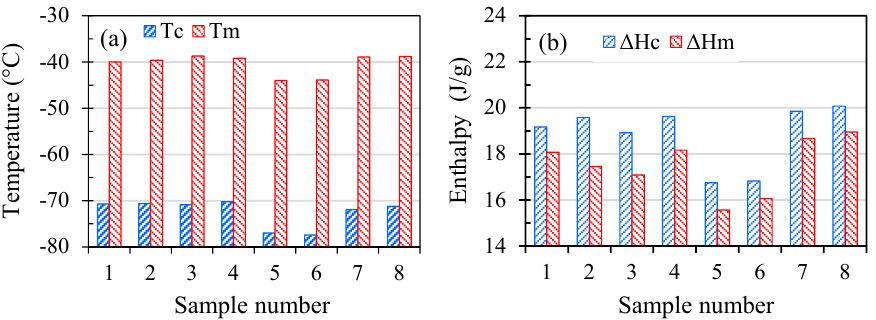
Figure 9. Variations of thermal properties of SR samples, ( a ) temperatures of crystallisation, T c , and melting, T m . ( b ) Enthalpies of crystallisation, Δ H c , and melting, Δ H m .